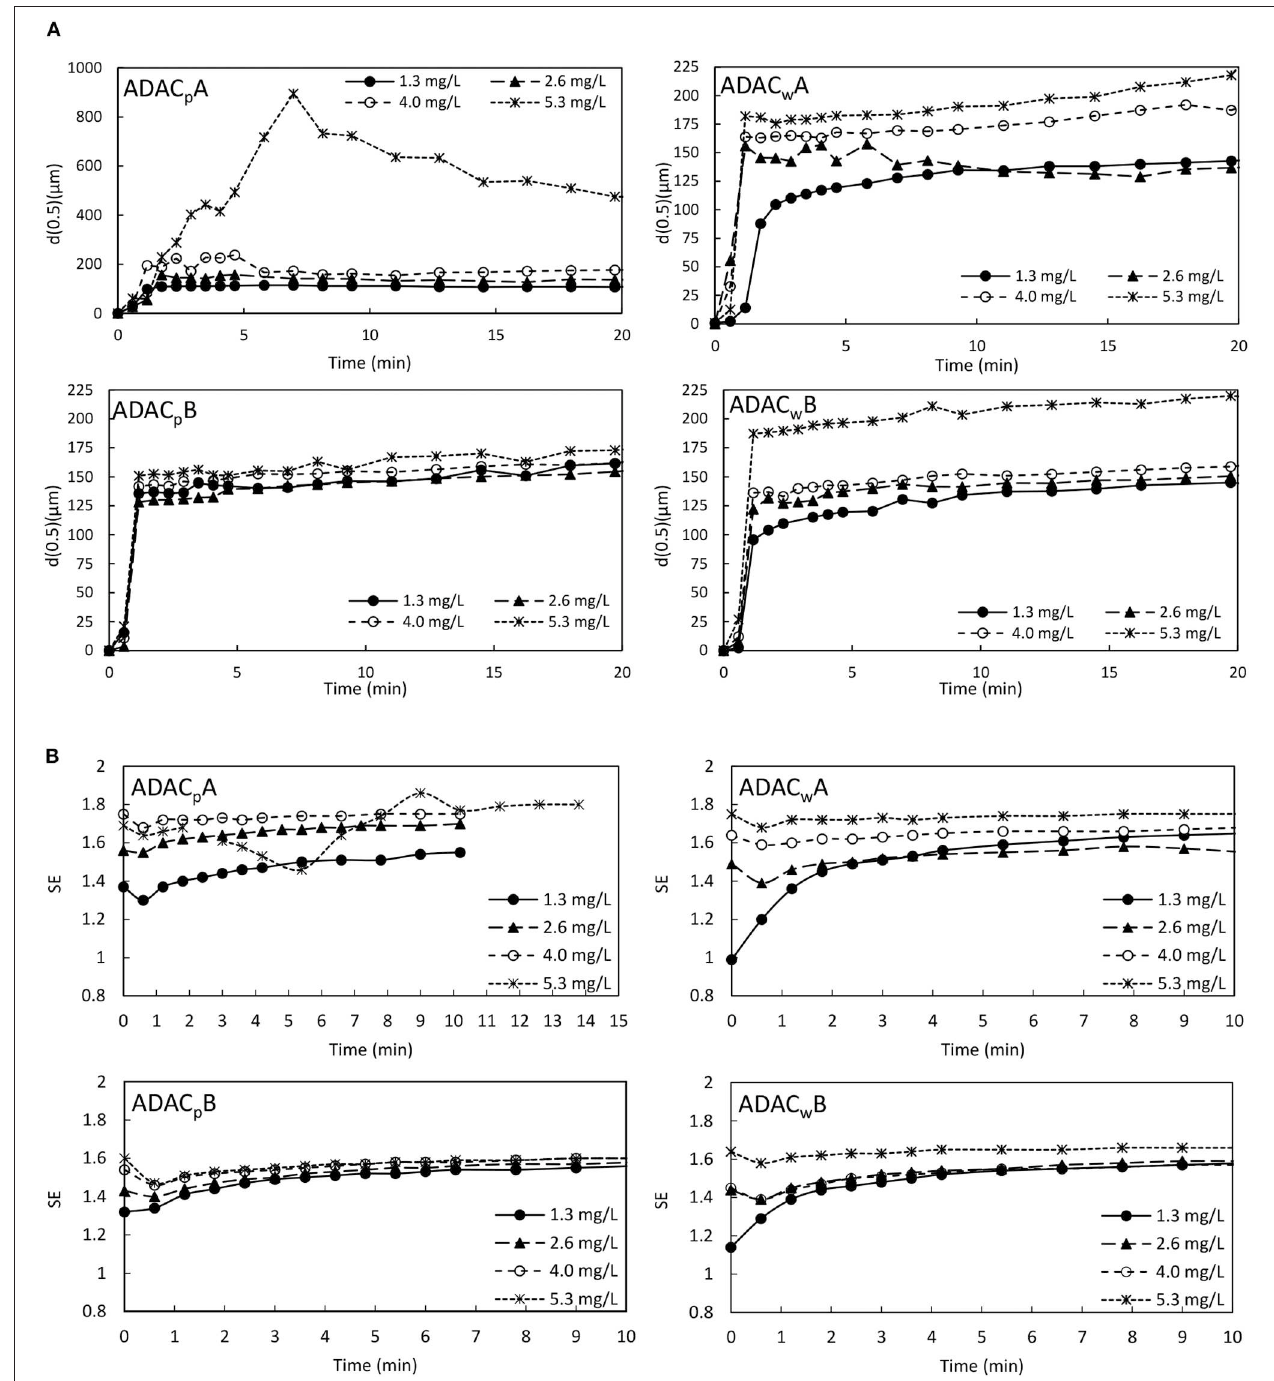
FIGURE 13 | (A) Industrial effluent treatment - evolution of (A) median particle size (d(0.5)) and (B) floc structure (SE) over time, obtained via LDS, for four different flocculant dosages of anionic cellulose-based polyelectrolytes obtained from bleached pulp, ADAC p A, B and obtained from pulp with kappa number of 26.7, ADAC w A, B, combined with